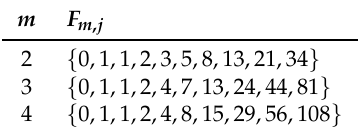
Table 1. M-bonacci sequences for different m